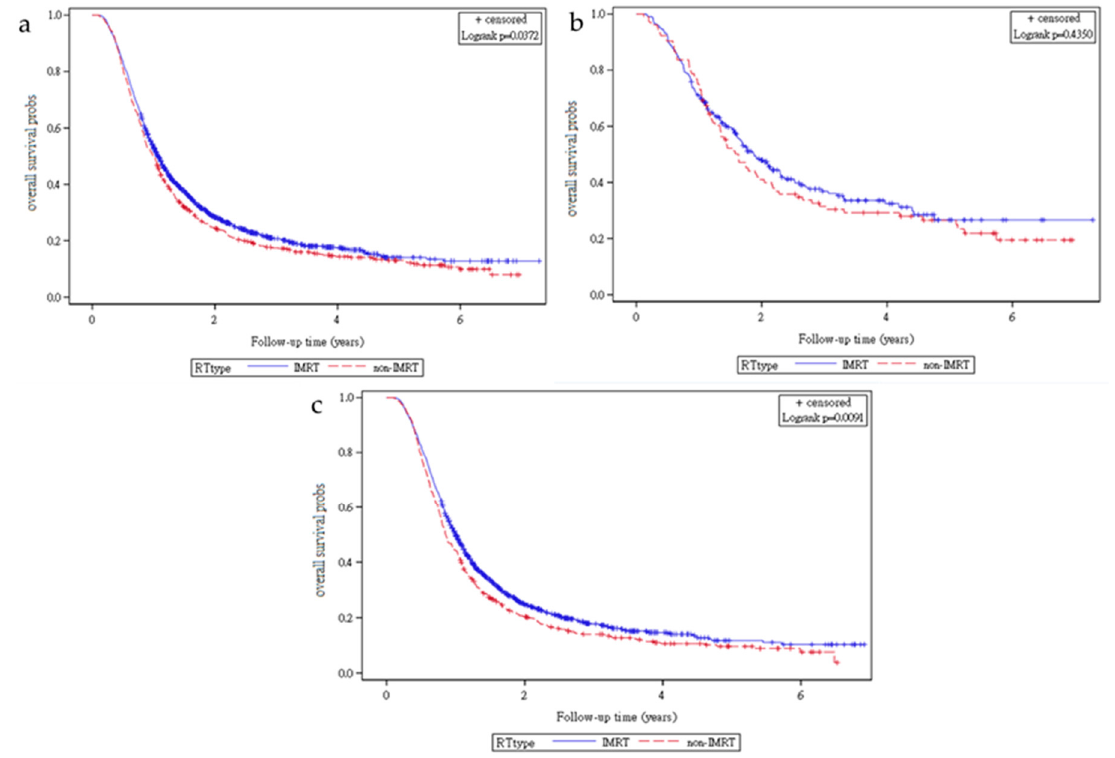
Figure 1. Kaplan–Meier curves for overall survival in patients undergoing various treatments. ( a ) All AJCC clinical stages. ( b ) Early AJCC clinical stage IA-IIB. ( c ) Advanced AJCC clinical stage IIIA-IIIB.